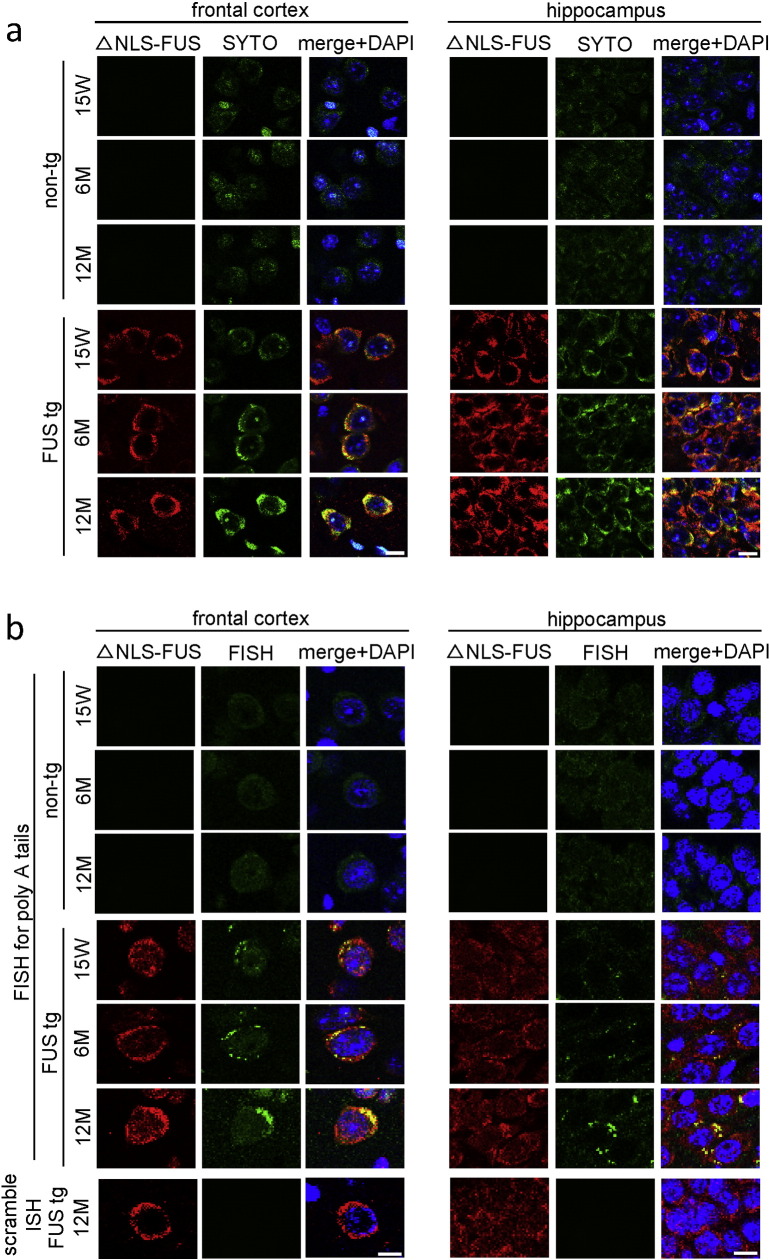
The signal of messenger ribonucleic acid (mRNA) was colocalized with the cytoplasmic FUS aggregates.(a) Frontal cortex and hippocampus of mice at 15 weeks of age was stained with anti-Myc (red) and SYTORNA select (green). (b) Double-fluorescence in situ hybridization staining for the poly-A tail of mRNA (green) and anti-Myc (red) in the frontal cortex and hippocampus of FUS transgenic and non-tg mice. The lower panel shows a scrambled probe staining serving as a negative control. Scale bar, 10 μm.